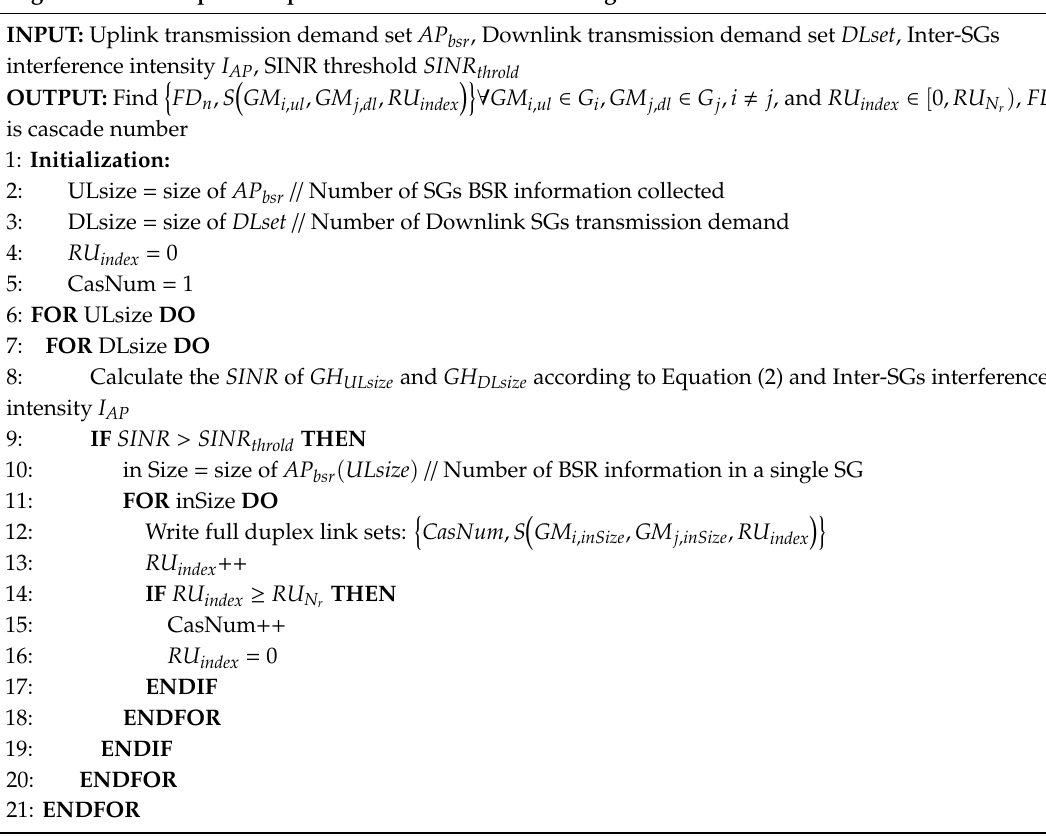
Algorithm 2: Group full duplex transmission in a cascading